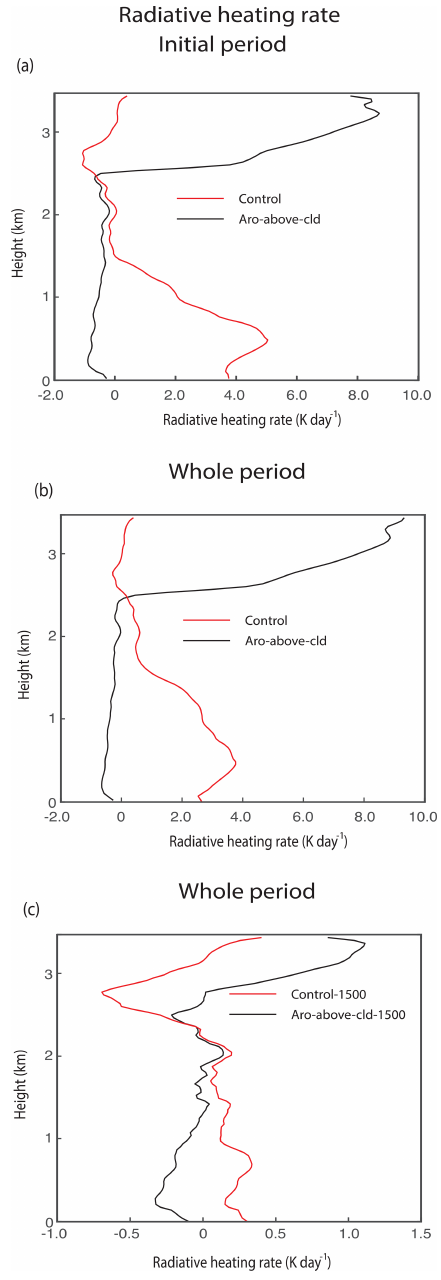
Figure 9. Vertical distributions of the time- and area-averaged ra- diative heating rate (a) in the control and aro-above-cld runs over the initial period between 10:00 and 13:50LST, (b) in the control and aro-above-cld runs, and (c) in the control-1500 and aro-above- cld-1500 runs over the whole simulation